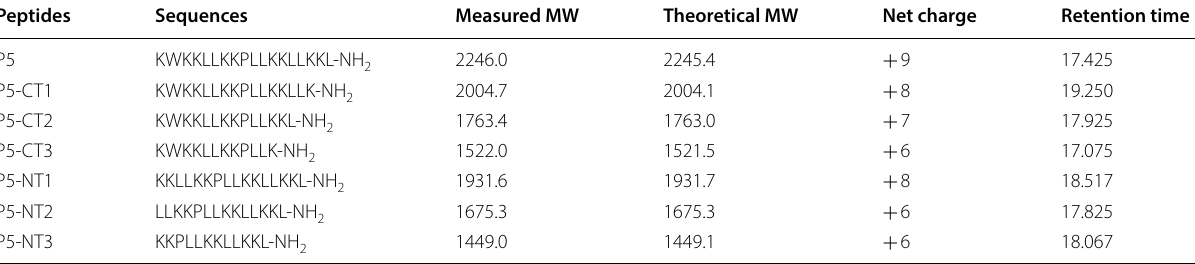
MW molecular weight, CT C-terminus, NT N-terminus